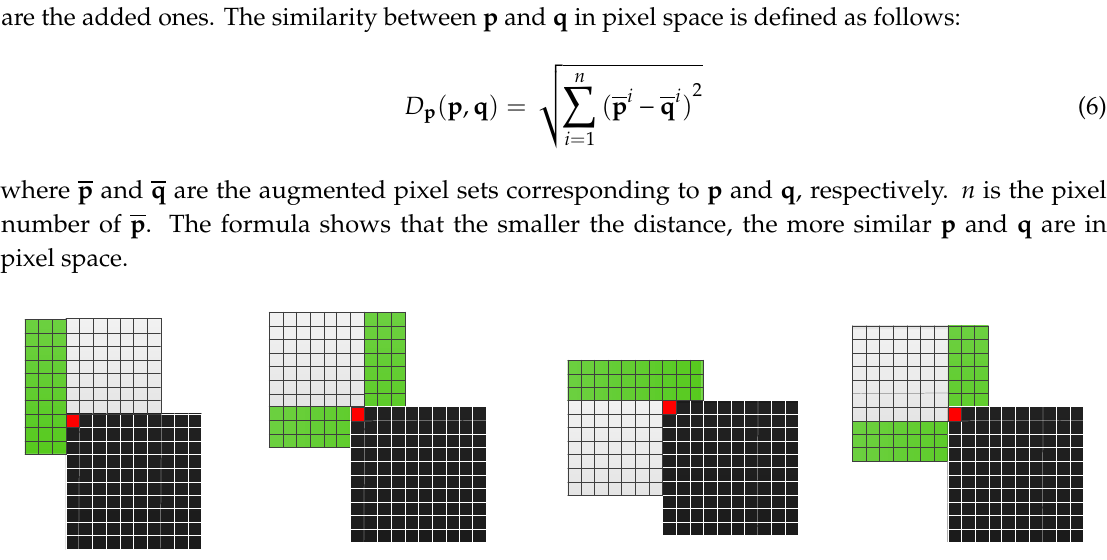
Figure 9. Structure of the augmented samples for selecting in pixel space. Each square stands for one pixel. The green part are the added pixels.